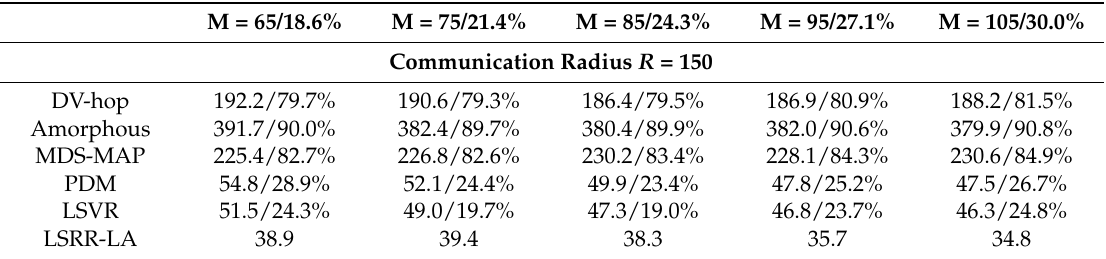
Table 6. Comparison of ALE under different numbers of anchors in the random deployment network. M = 65/18.6%